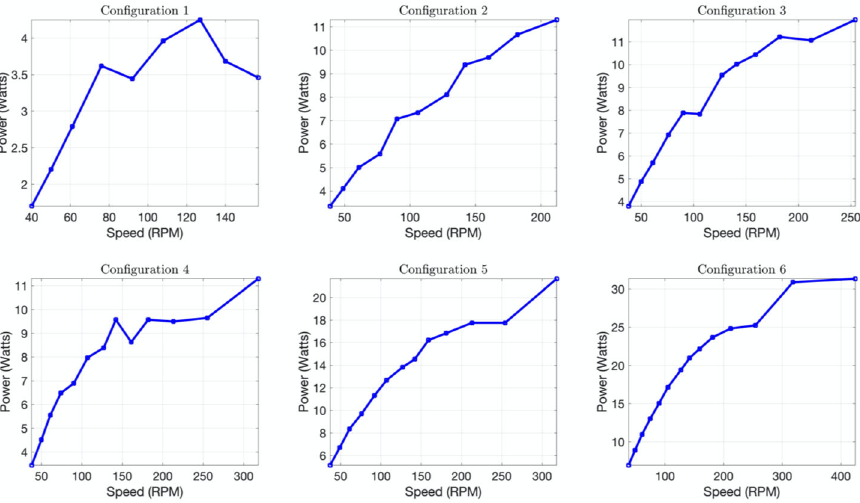
Figure 14. Speed–power performance for all six configurations in AFM.